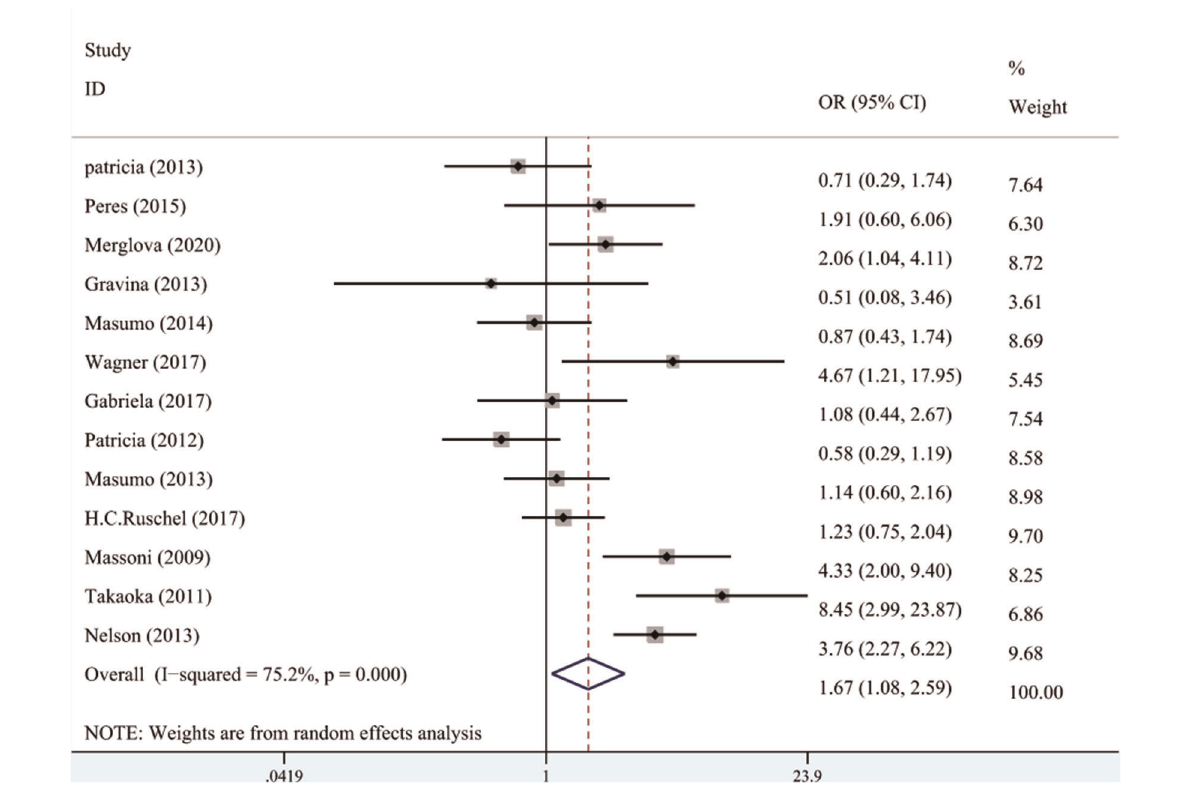
FIGURE 2 The forest plot shows the relationship between PT and DDE in primary teeth (REM). PT, preterm; DDE, developmental defects of